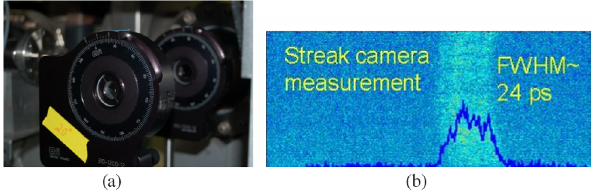
FIG. 5. Laser pulse stacking characterization. (a) The crystal setup used during the experiment and (b) streak camera mea- surement of the temporal laser profile after the